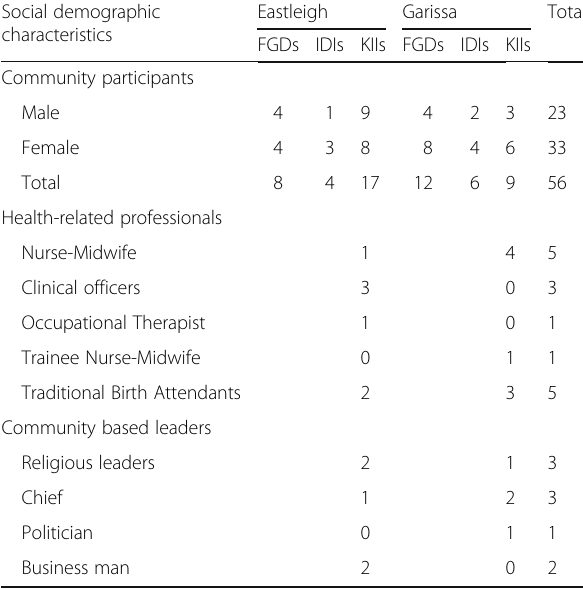
Table 1 Overview of the study participants Social demographic